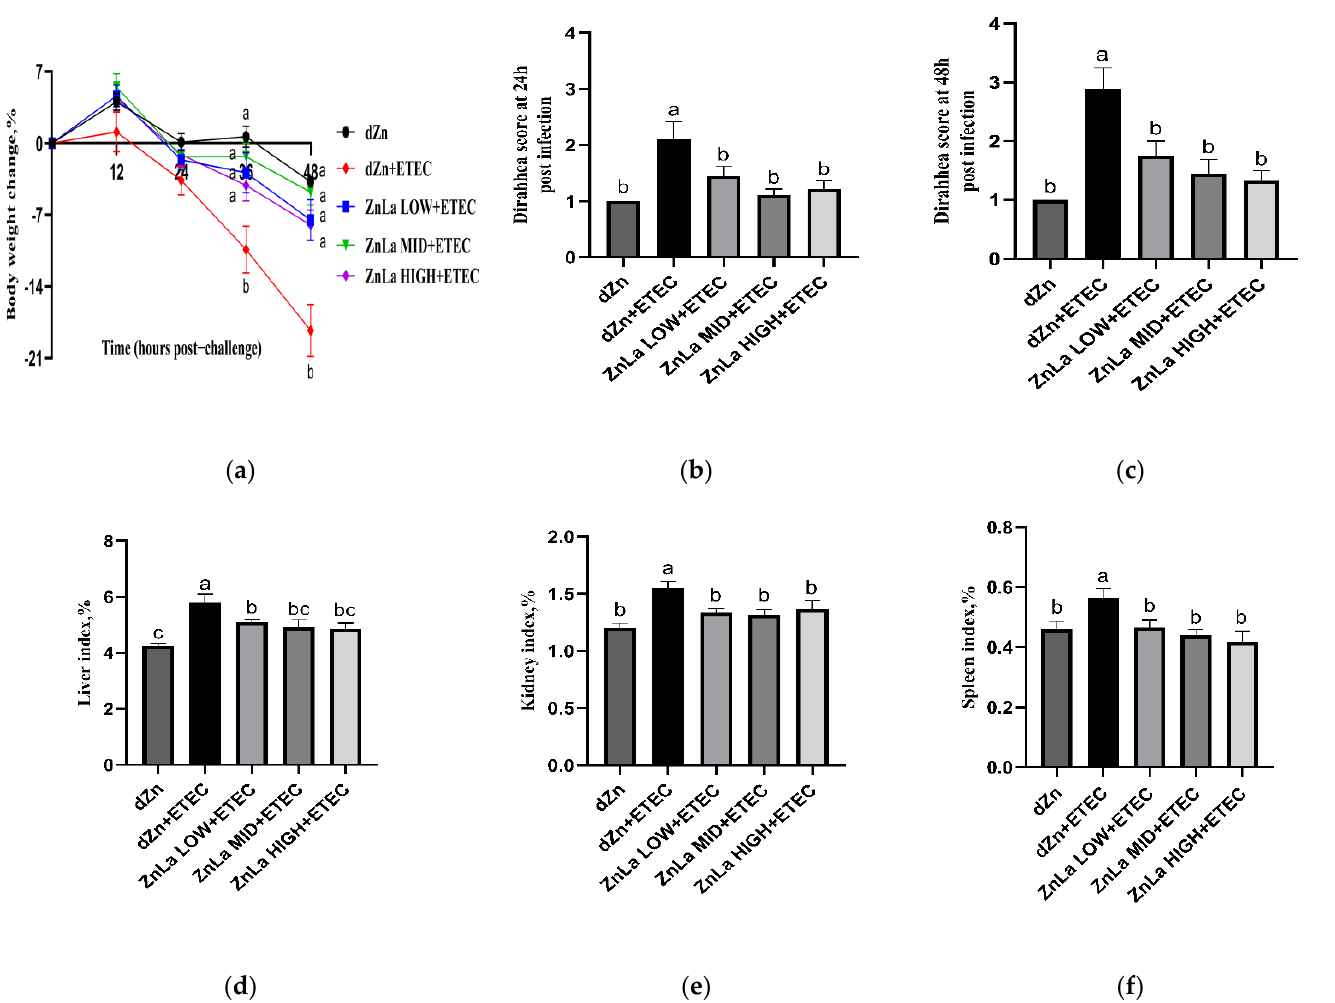
Figure 1. Effects of ZnLa on the clinical symptoms in mice with ETEC challenge. ( a ) Body weight change from 0 to 48 h. ( b , c ) The diarrhea score at 24 and 48 h. ( d – f ) The liver index, kidney index, and spleen index. The data are expressed as mean ± s.e.m (n = 9), and different lowercase letters in each group show significant differences ( p < 0.05).